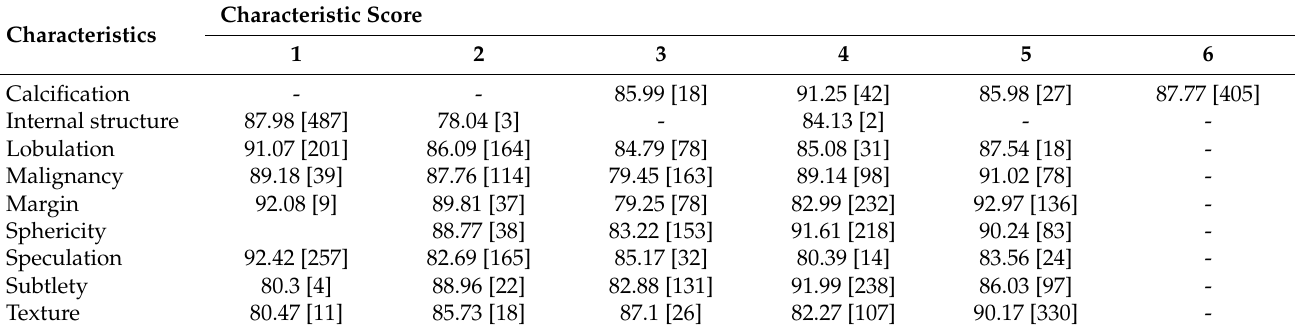
Table 2. Mean dice score for various types of nodules from the LIDC-IDRI testing set.